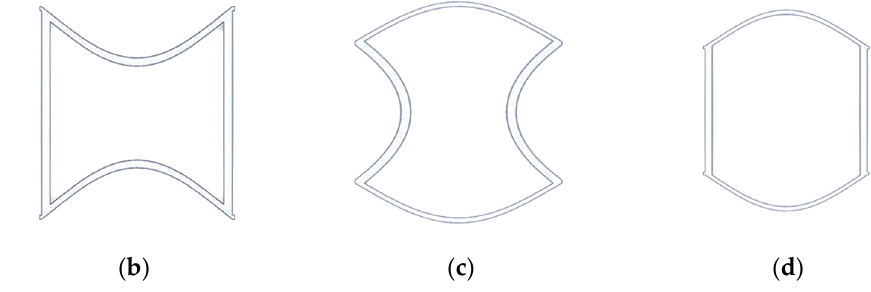
Figure 8. SIN waveforms: ( a ) A, ( b ) A’, ( c ) B, and ( d ) B’